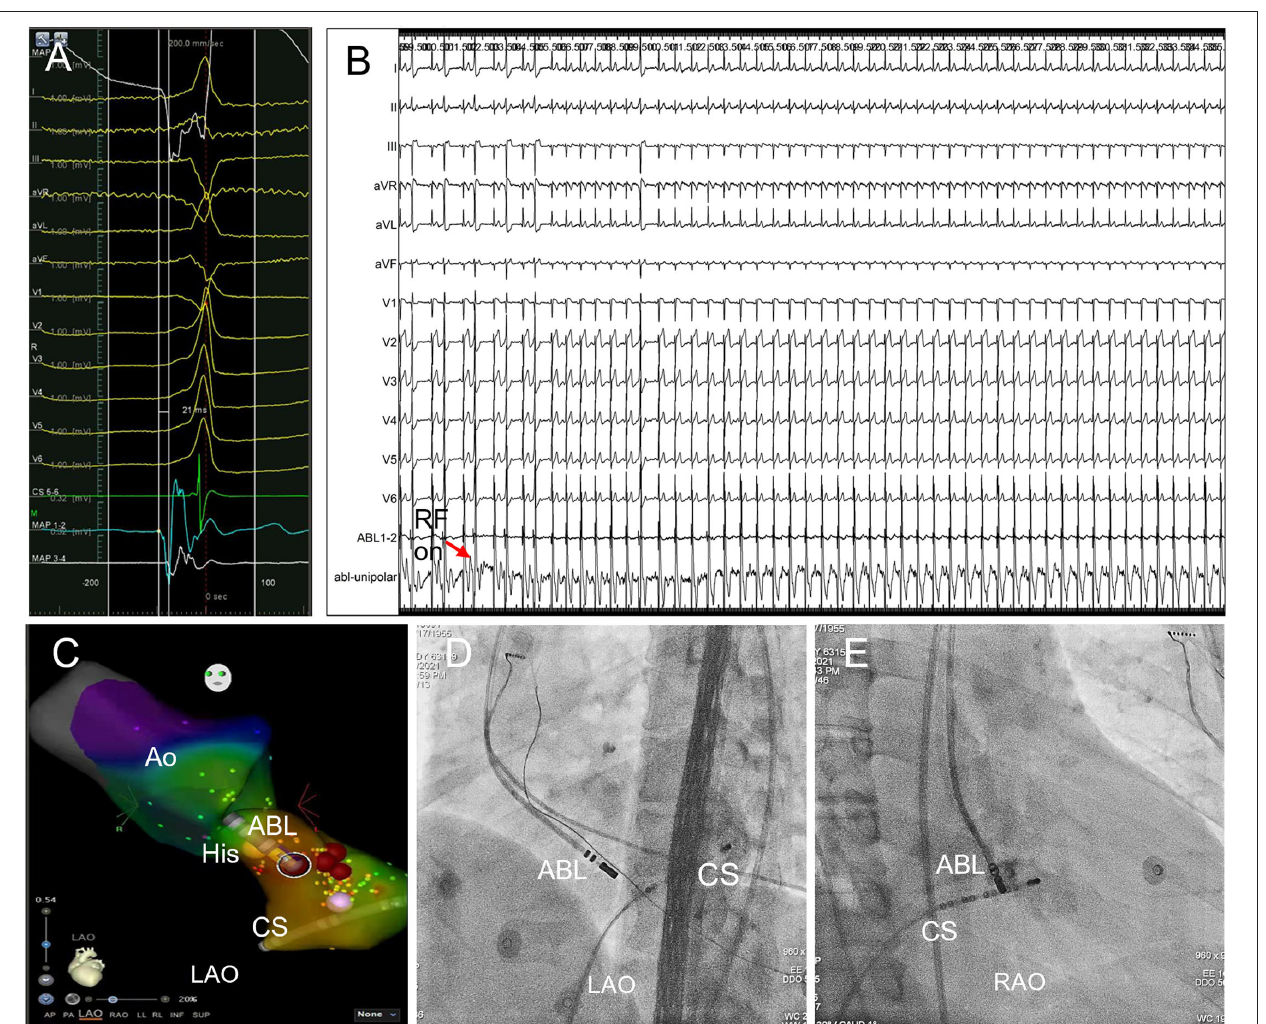
FIGURE 3 | Trans-aortic retrograde ablation of left PHVA. (A) Tracings were unipolar MAP1, twelve-lead surface ECG, CS 5 − 6 , bipolar MAP 1 − 2 , MAP 3 − 4 . The local bipolar electrogram at the ablation target preceded the QRS onset by 21ms with a sharp “QS” unipolar electrogram. (B) RF ablation 30W, 60s at the sub-aortic ablation target successfully eliminated the left PHVA without causing PR prolongation or AVB. (C) Activation mapping of the left PHVA region and the aortic root. The catheter tip was positioned at the ablation target ≈ 3mm below the HB in the left ventricle. Ablation attempt (30W, 10s) was not effective at other sites slightly away from the ablation target. Red dots represented ablation lesions. (D,E) The catheter placement at the left parahisian region on LAO and RAO fluoroscopic projection. Ao, the aorta; HB, the His bundle; CS, coronary sinus; ABL, the ablation catheter; RAO, right anterior oblique; LAO, left anterior